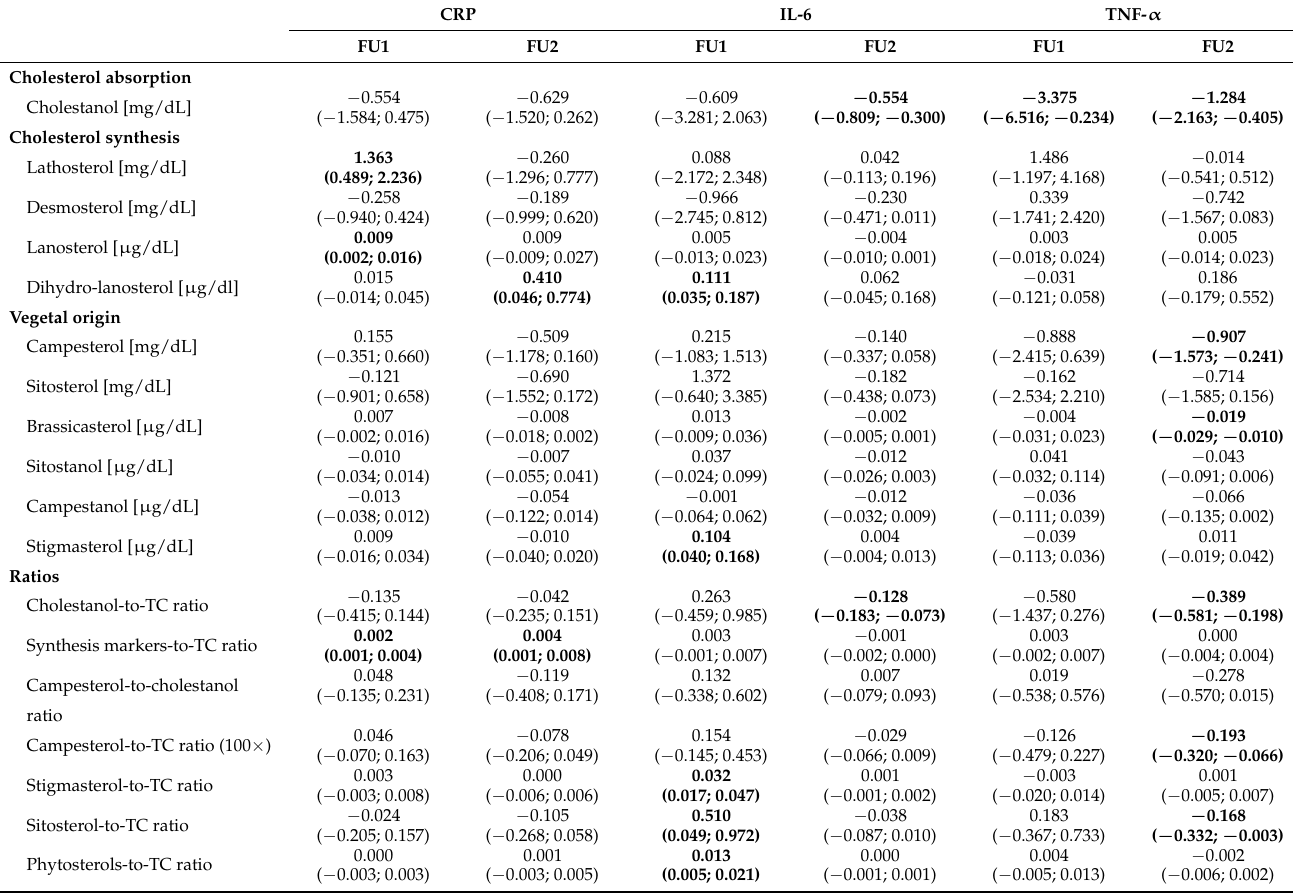
Table 3. Robust regression between inflammatory markers and serum sterol levels and ratios,